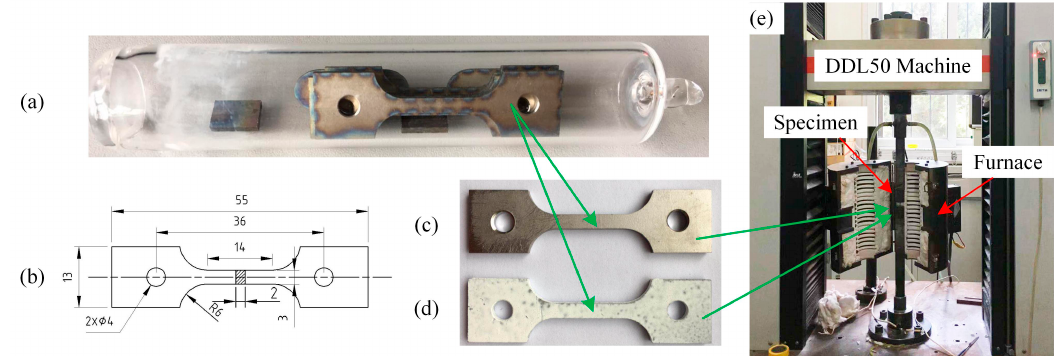
Figure 2. ( a ) Specimens in quartz glass tubes; ( b ) Diagram of specimen used in tensile tests (Unit: mm); ( c ) Specimen without antioxidant; ( d ) Specimen with antioxidant; ( e ) DDL50 electronic testing machine.